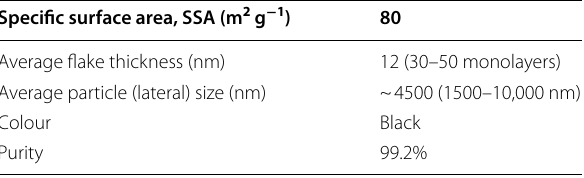
Table 1 Properties of the graphene.